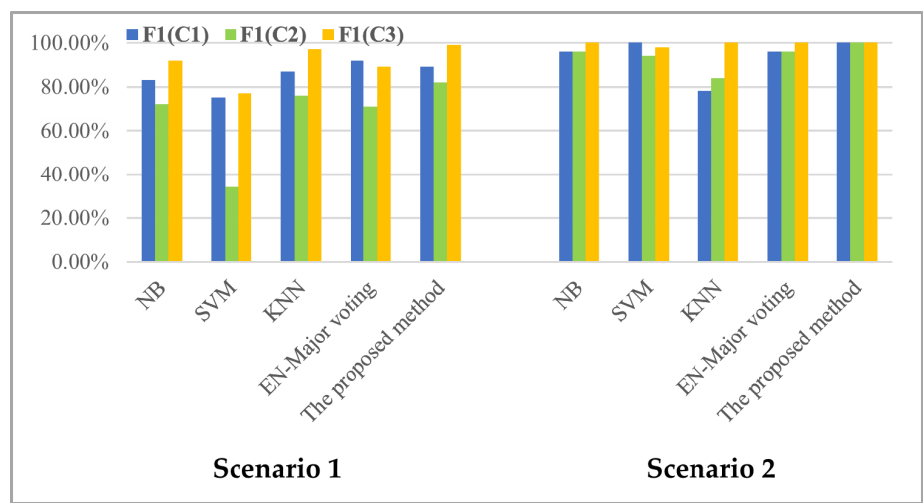
Figure 18. The results of testing the algorithms under two scenarios in the process of fault classification. Table 10. Comparative results between the proposed method and other